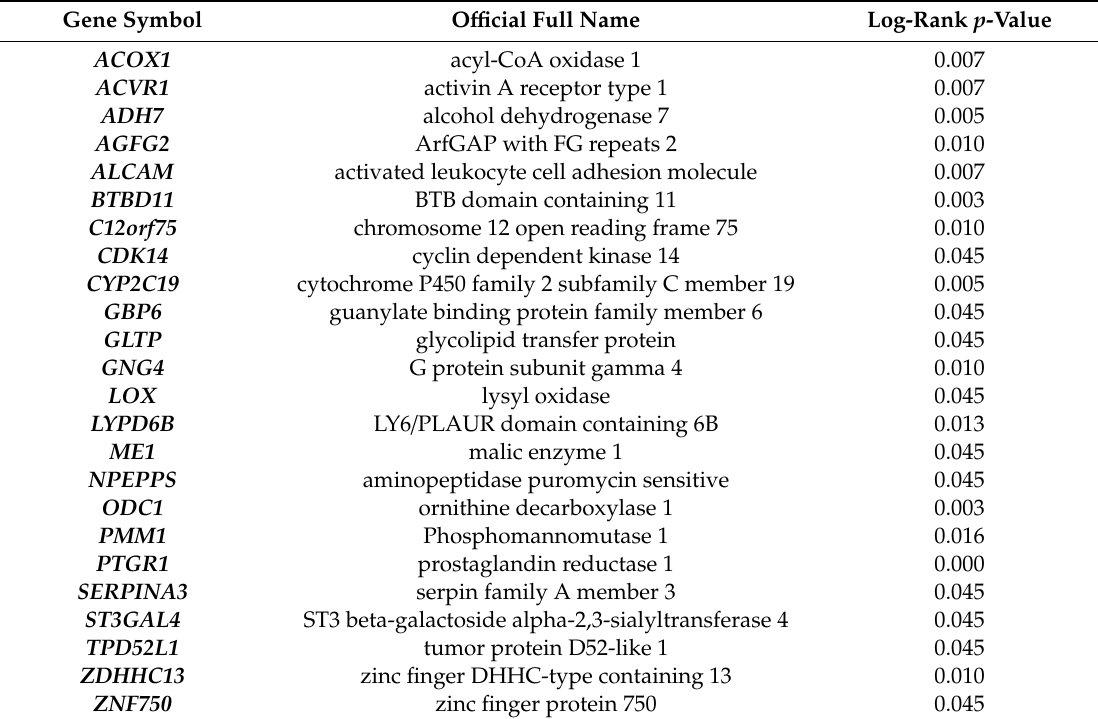
Table 1. Overexpressed genes associated to LSCC prognosis in the validation set of samples.